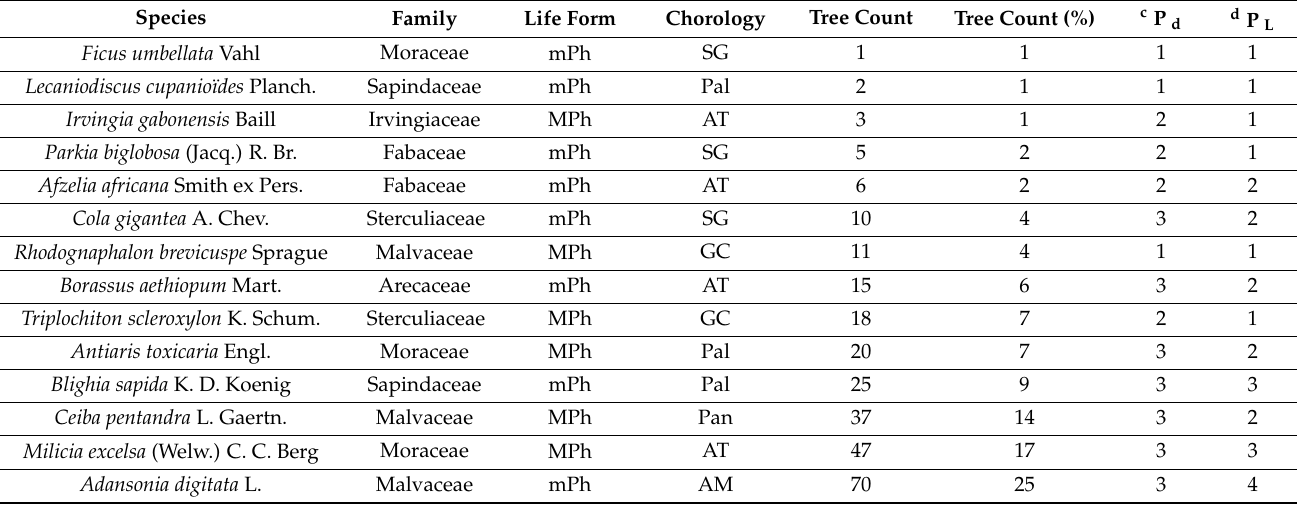
Table 2. Botanical information, species composition, and presence of LOTs in their site of